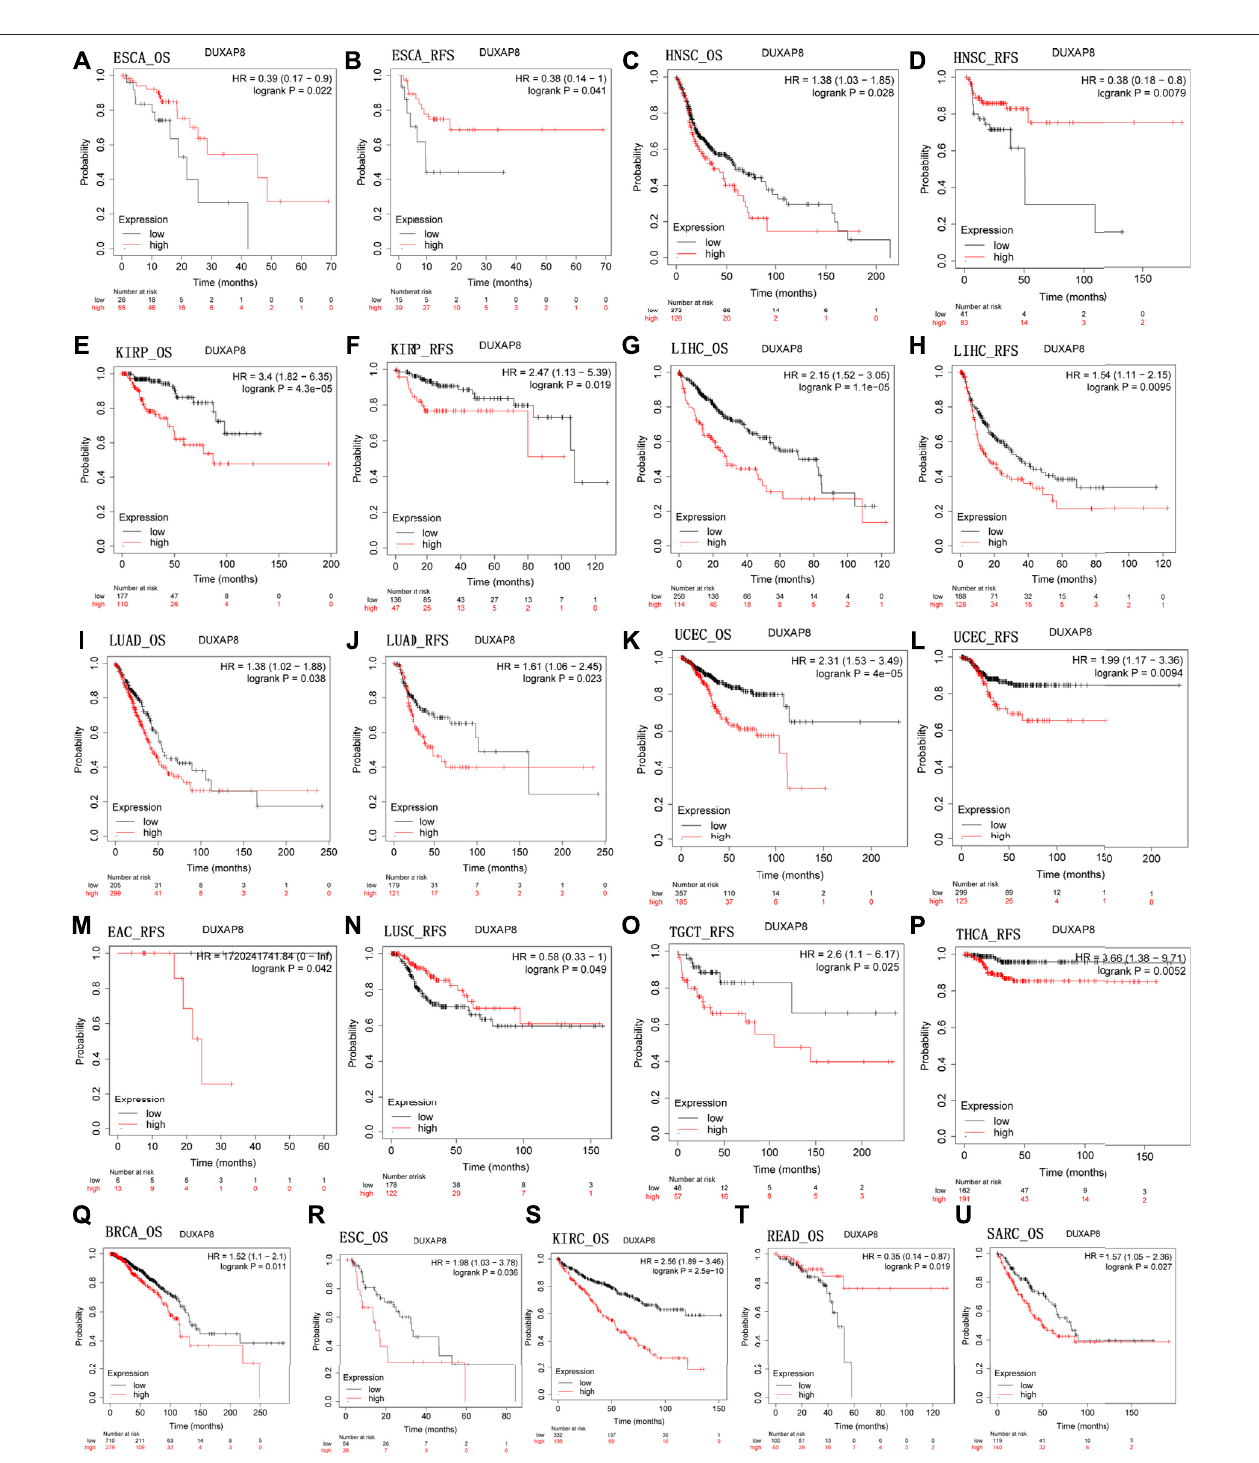
FIGURE 4| Kaplan-Meier survival curves comparingthe high and low expression of DUXAP8 gene in various cancer types in Kaplan-MeierPlotter. OSand RFS of (A,B) ESCA, (C,D) HNSC, (E,F) KIRP, (G,H) LIHC, (I,J) LUAD, (K,L) UCEC. RFS of (M) EAC, (N) LUSC, (O) TGCT, and (P) THCA. OS of (Q) BRCA, (R) ESC, (S) KIRC, (T) READ, and (U) SARC. OS, overall survival; RFS, relapse-free survival.